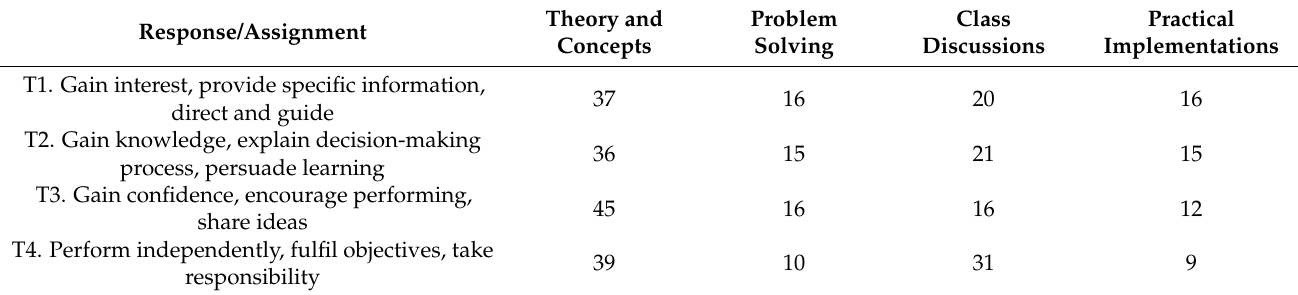
Table 10. Average percentage of responses for the least helpful lecture components (excluding blank, void, and other